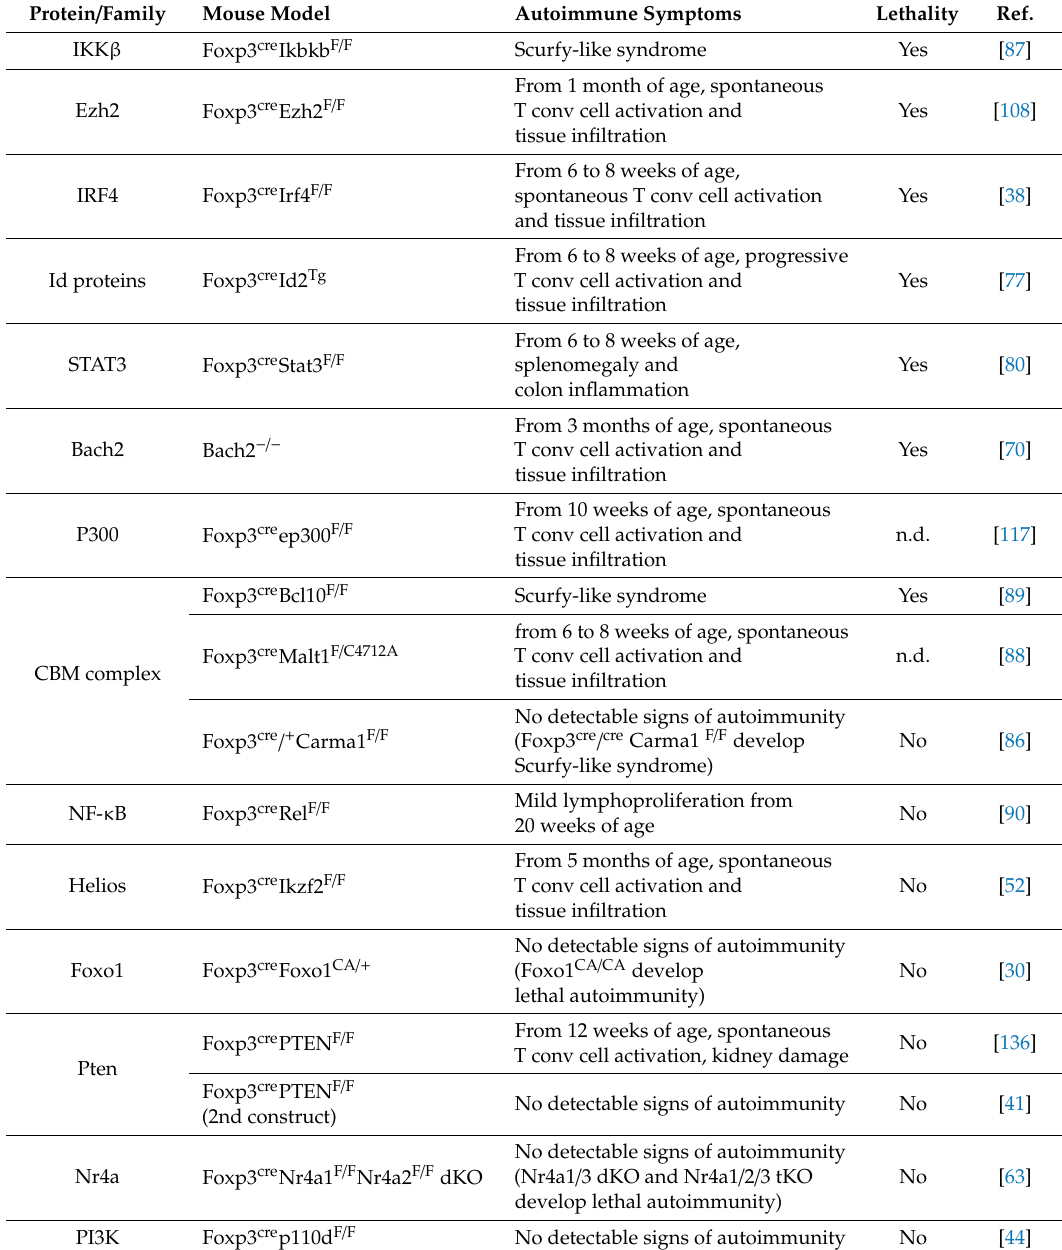
Table 1. Autoimmune symptoms in mice with enhanced anti-tumor immunity. Models are ranked by severity of the